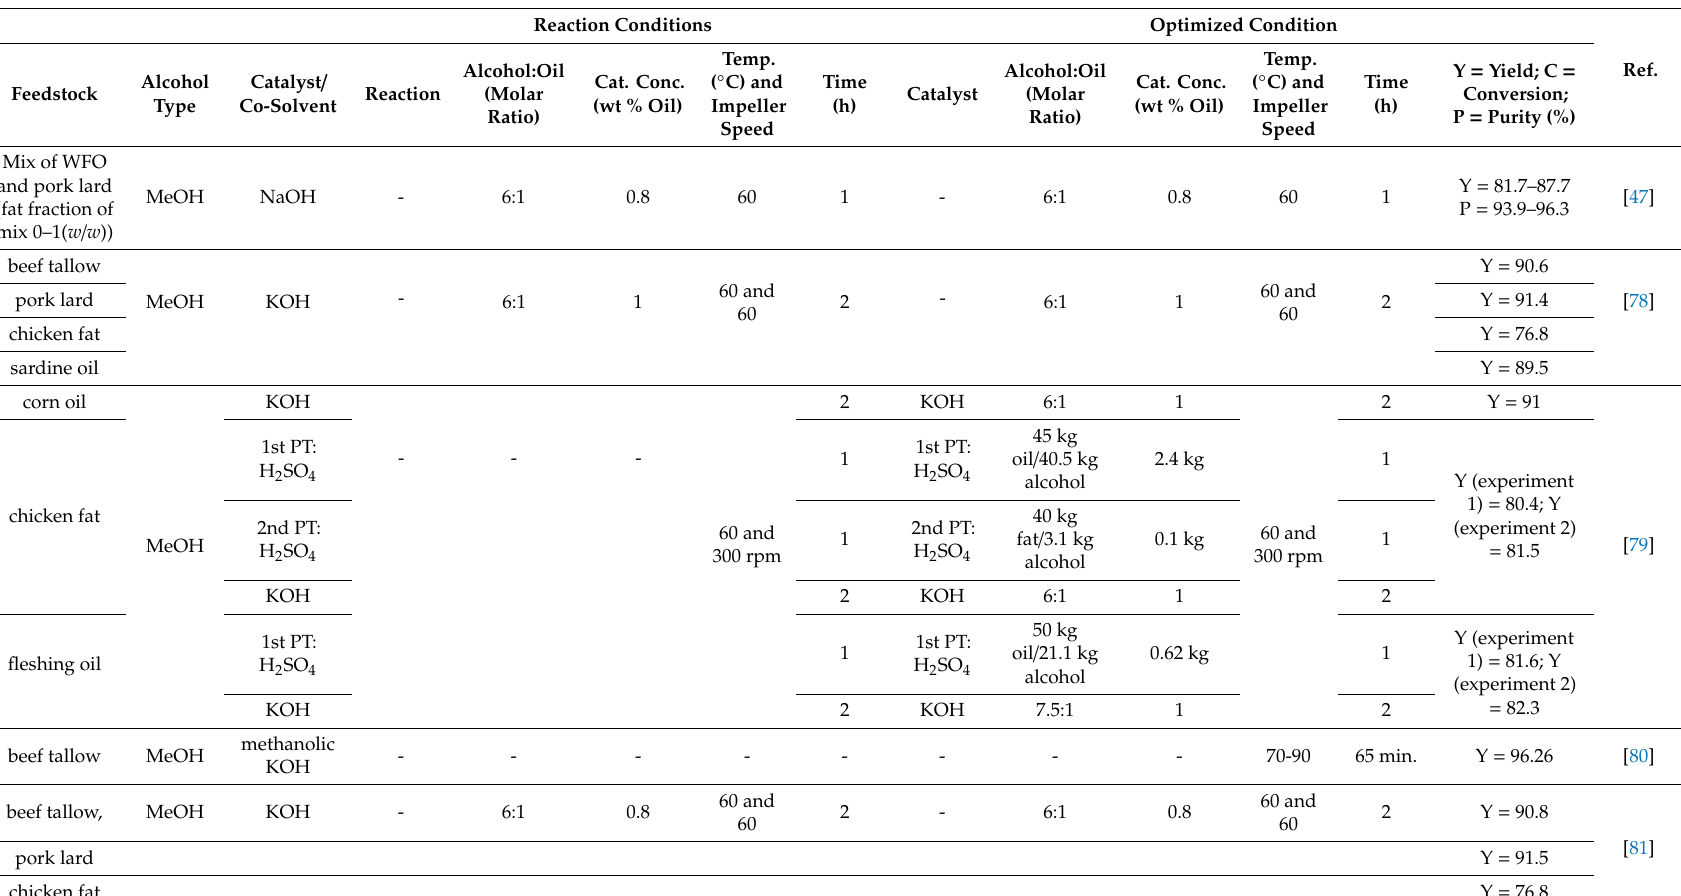
Table 6. Review of homogeneous catalysis to process animal